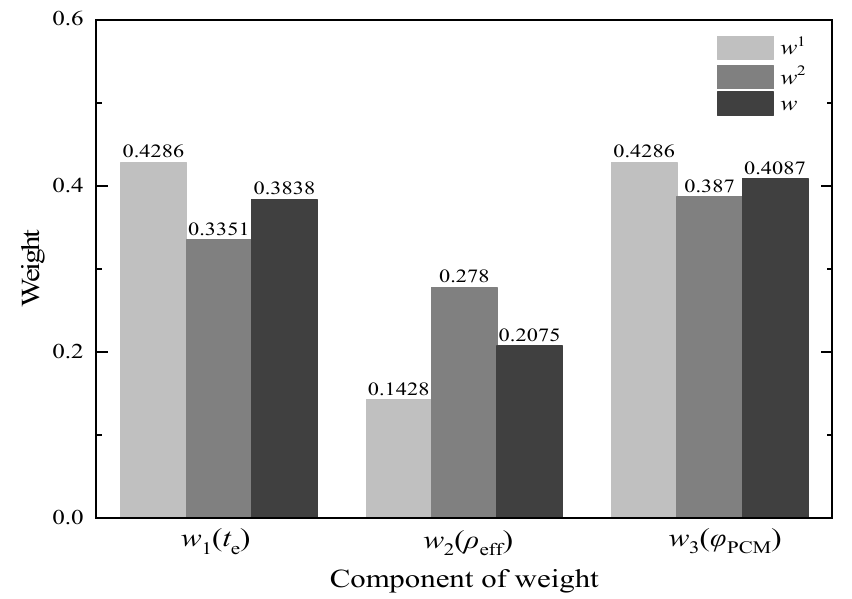
Figure 10. Subjective and objective weights of alternatives’ performance characteristics.